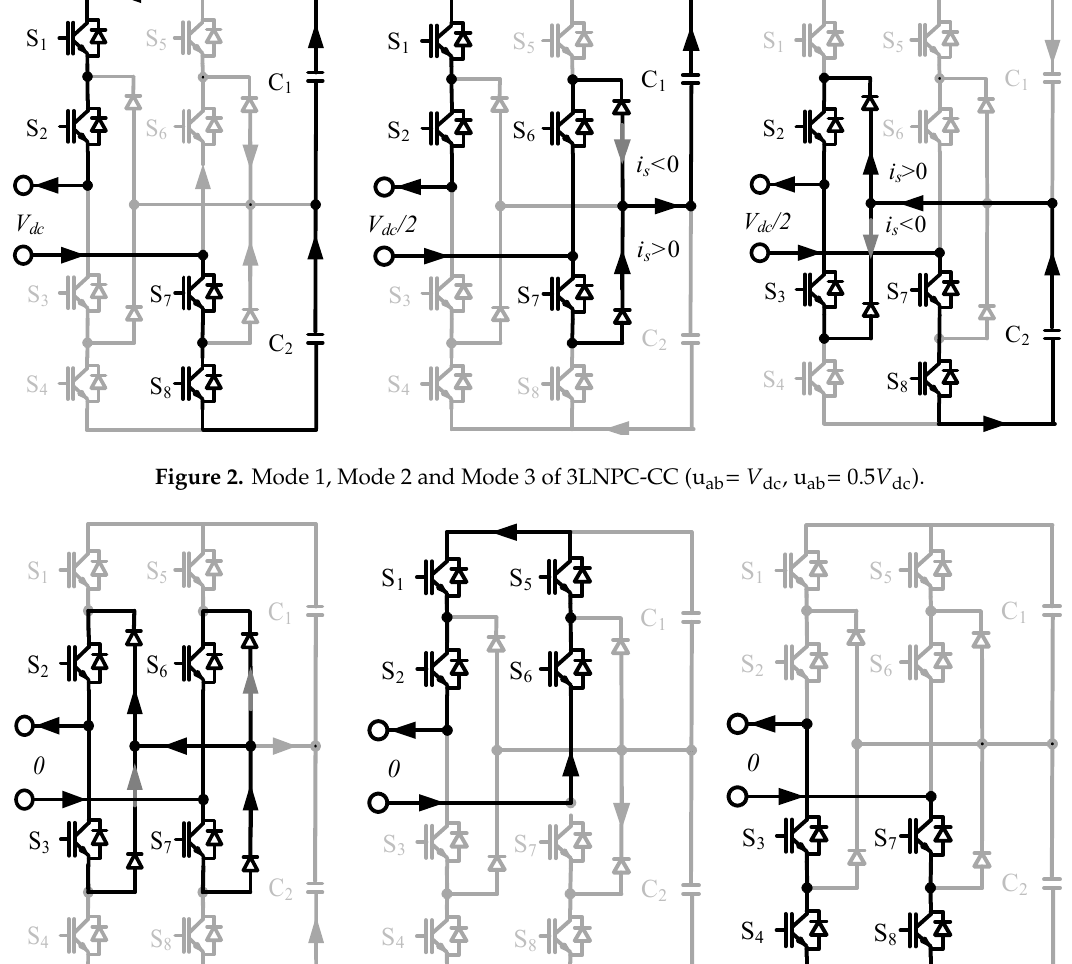
Figure 2. Mode 1, Mode 2 and Mode 3 of 3LNPC-CC (u ab = V dc , u ab = 0.5 V dc ).